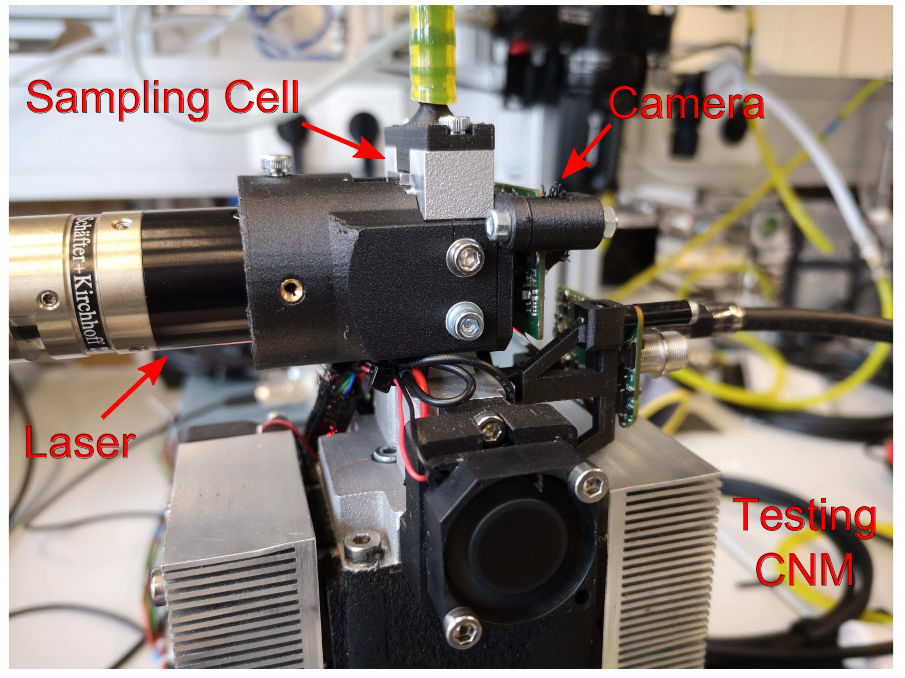
Figure 3. Particle Imaging Unit (PIU) ontop of the testing CNM